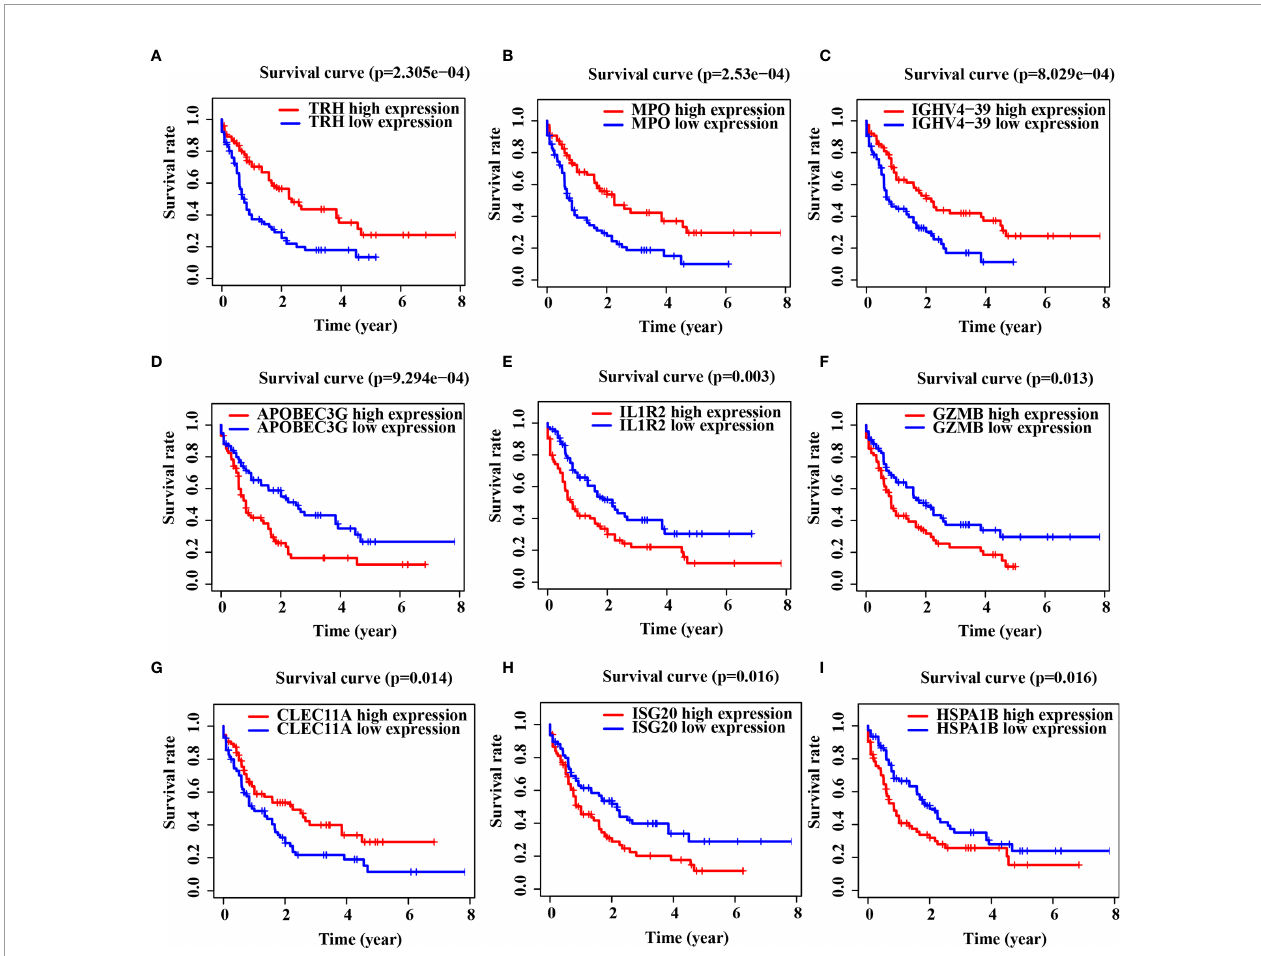
FIGURE 1 | Immune-related genes (IRGs) associated with the overall survival (OS) of acute myeloid leukemia (AML) patients. (A – I) Kaplan – Meier curve analysis of nine representative IRGs in TCGA-LAML